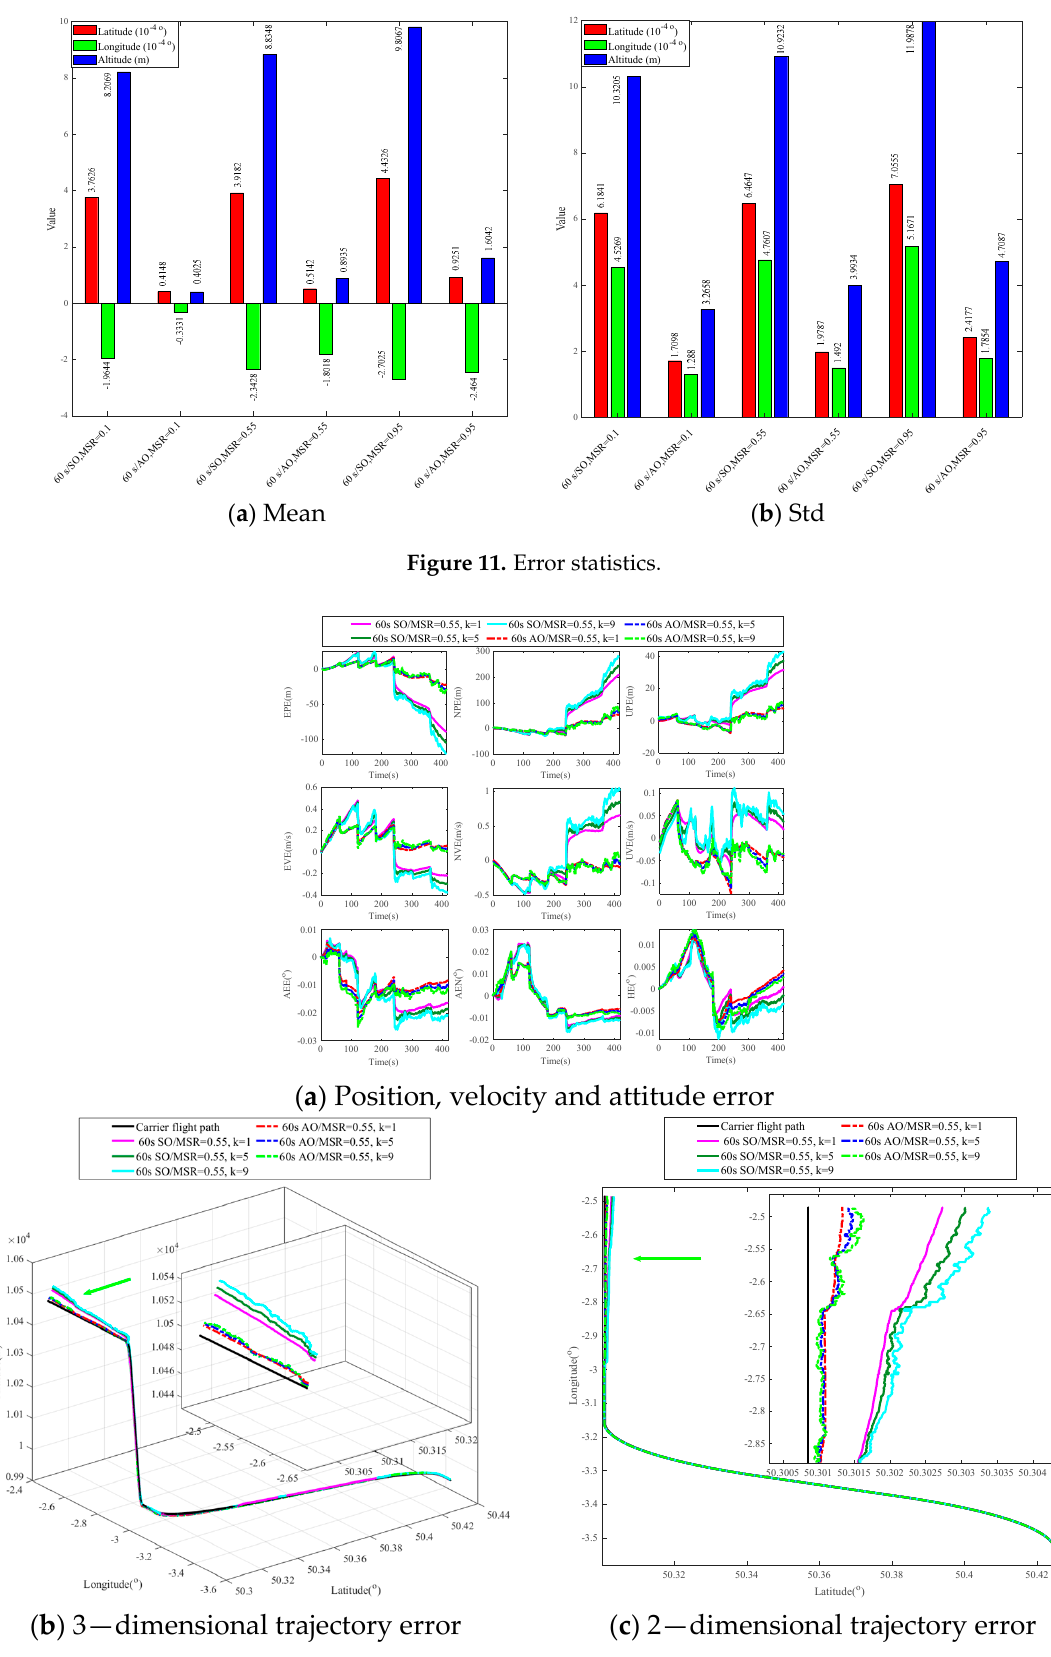
Figure 12. Errors under Different Noise Intensities.